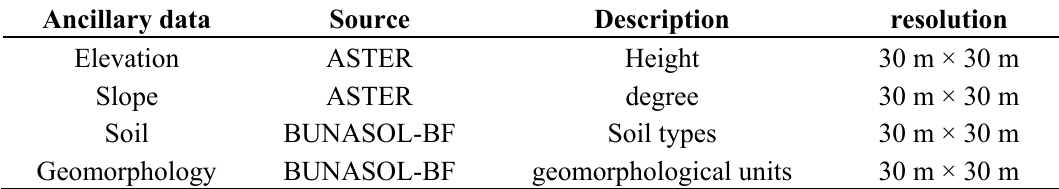
Table 2. Ancillary data used in LULC